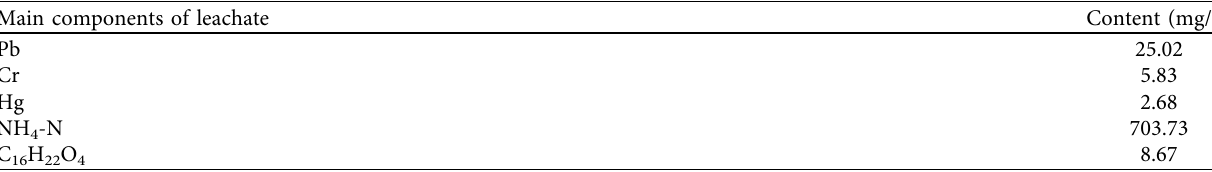
Figure 8: Self-made adsorption infiltrator and its working principle. Table 7: Composition of landfill leachate prepared in laboratory.